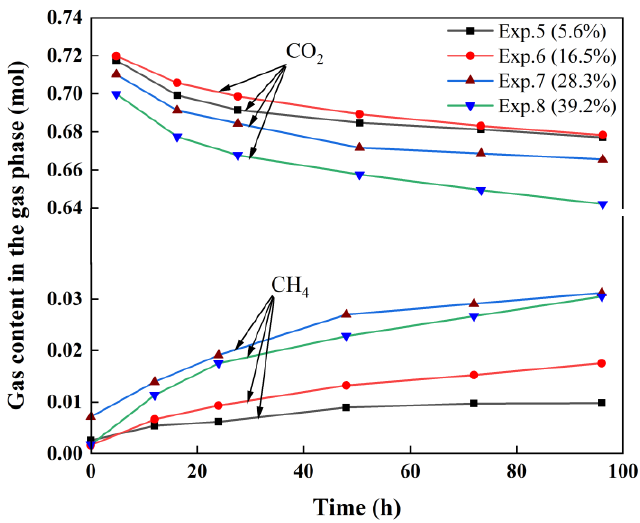
Figure 10. Variation in the gas content in the gas phase for Experiments 5, 6, 7, and